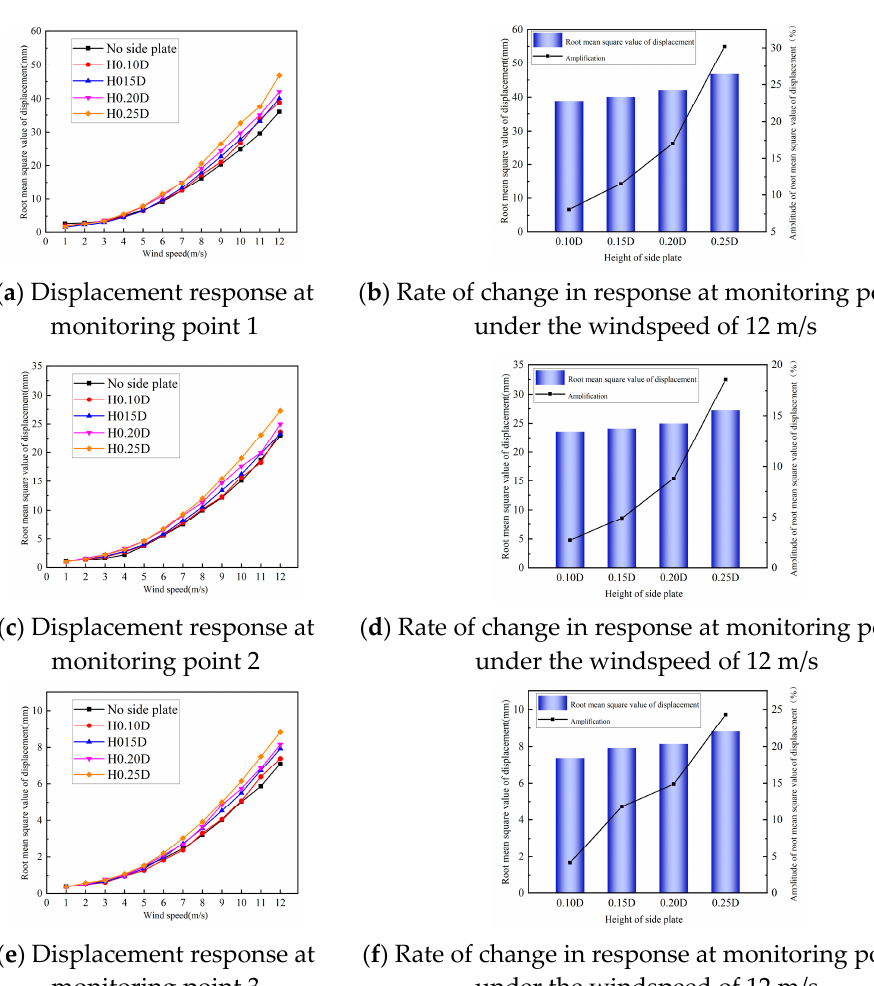
Figure 25. Root mean square value of the along-wind displacement response at the monitoring points